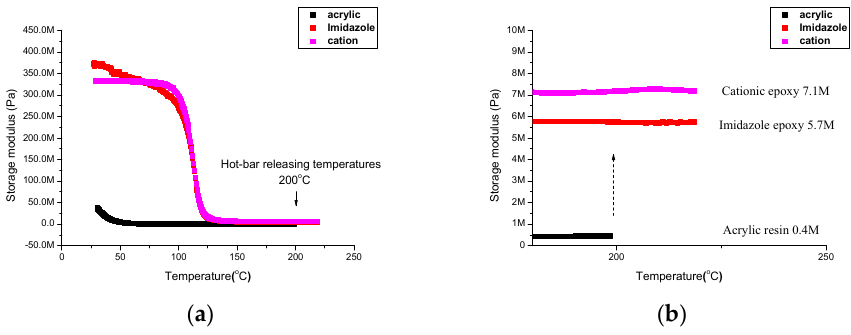
Figure 18. Thermal mechanical properties of typical adhesives films. ( a ) 30 °C–250 °C ( b ) magnified 200 °C–250 °C.